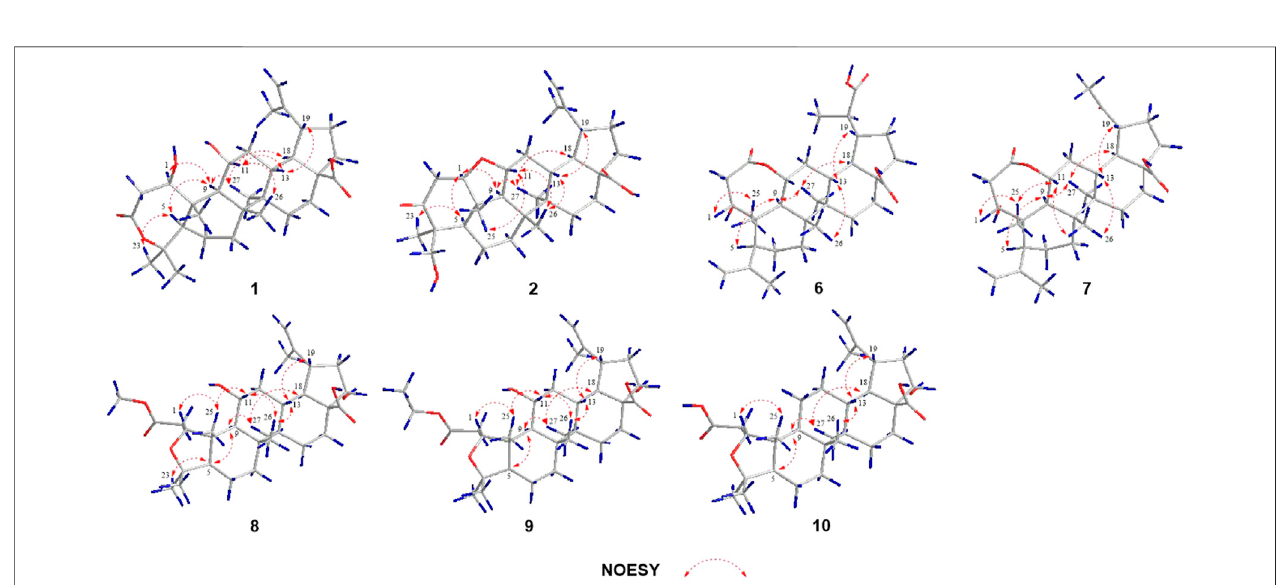
FIGURE 3 | Key NOESY correlations of compounds 1 - 2 , 6 - 10